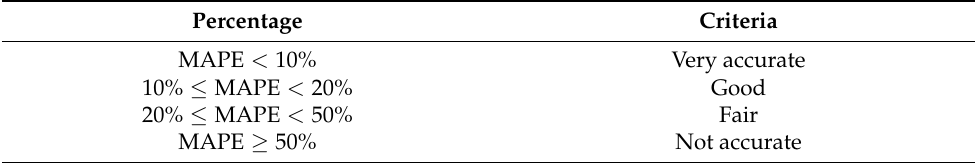
Table 1. Criteria for the MAPE score.